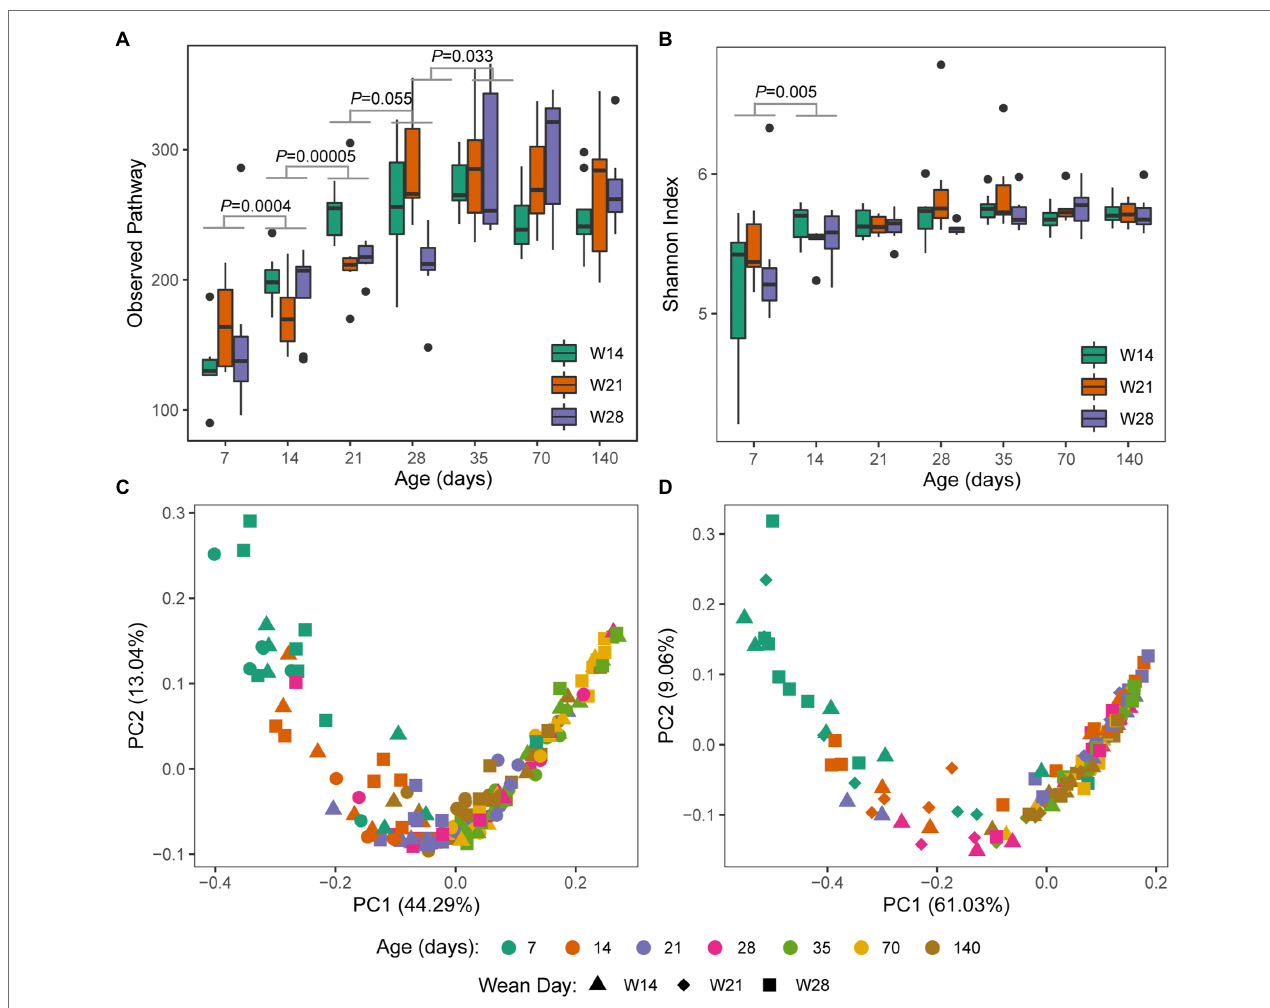
FIGURE 3 | Archaeal functional diversity in swine gut by weaning age over time. (A) Observed KEGG Pathways (presence or absence), (B) KEGG Shannon diversity, (C) PcoA plot based on KEGG pathway membership (Jaccard similarity), and (D) PcoA plot based on KEGG pathway structure (Bray–Curtis similarity). Significance determined by Kruskal–Wallis (pairwise) test for both alpha diversity indices (Observed Pathway and Shannon index). Values of p between groups are labeled above groups when p ≤ 0.05. There is no difference between groups ( p > 0.05) if not indicated